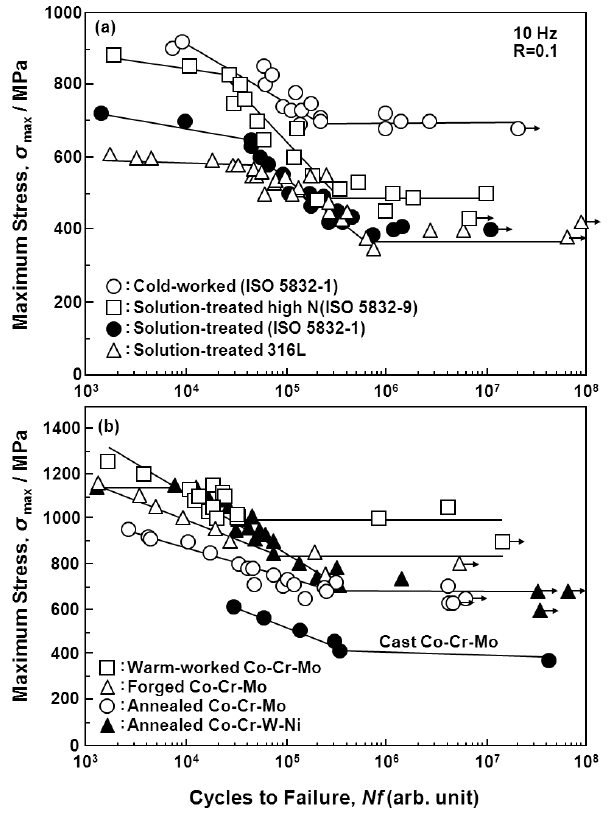
Figure 8. Comparison of S-N curves obtained by tension-to-tension fatigue test in Eagle’s medium at 37 °C for ( a ) stainless steels; and ( b ) Co-Cr-Mo alloys treated under various conditions.